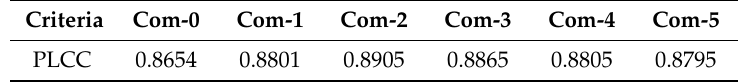
Table 5. Experimental results of the order selection of derivatives for IHOG features on